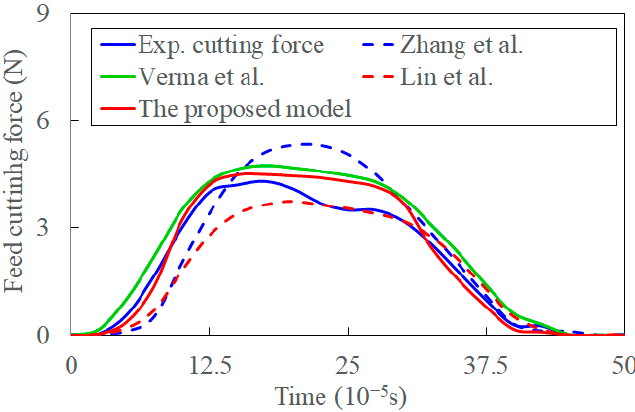
Figure 17. The predicted and experimental transient cutting force in the feed direction.